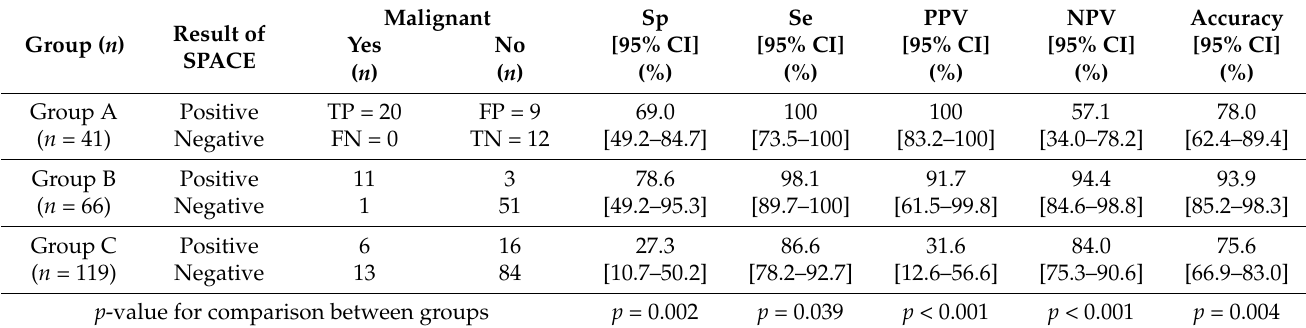
Table 2. Diagnostic ability of SPACE for pancreatic carcinoma and malignant IPMN.